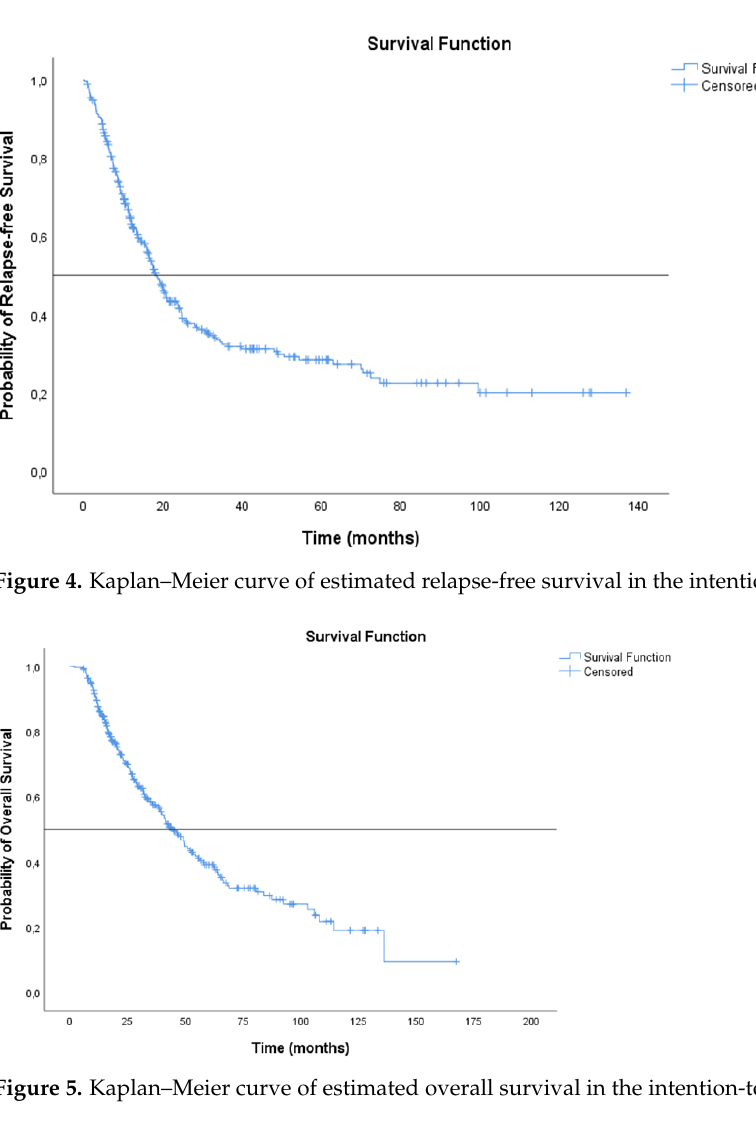
Figure 5. Kaplan–Meier curve of estimated overall survival in the intention-to-treat population.